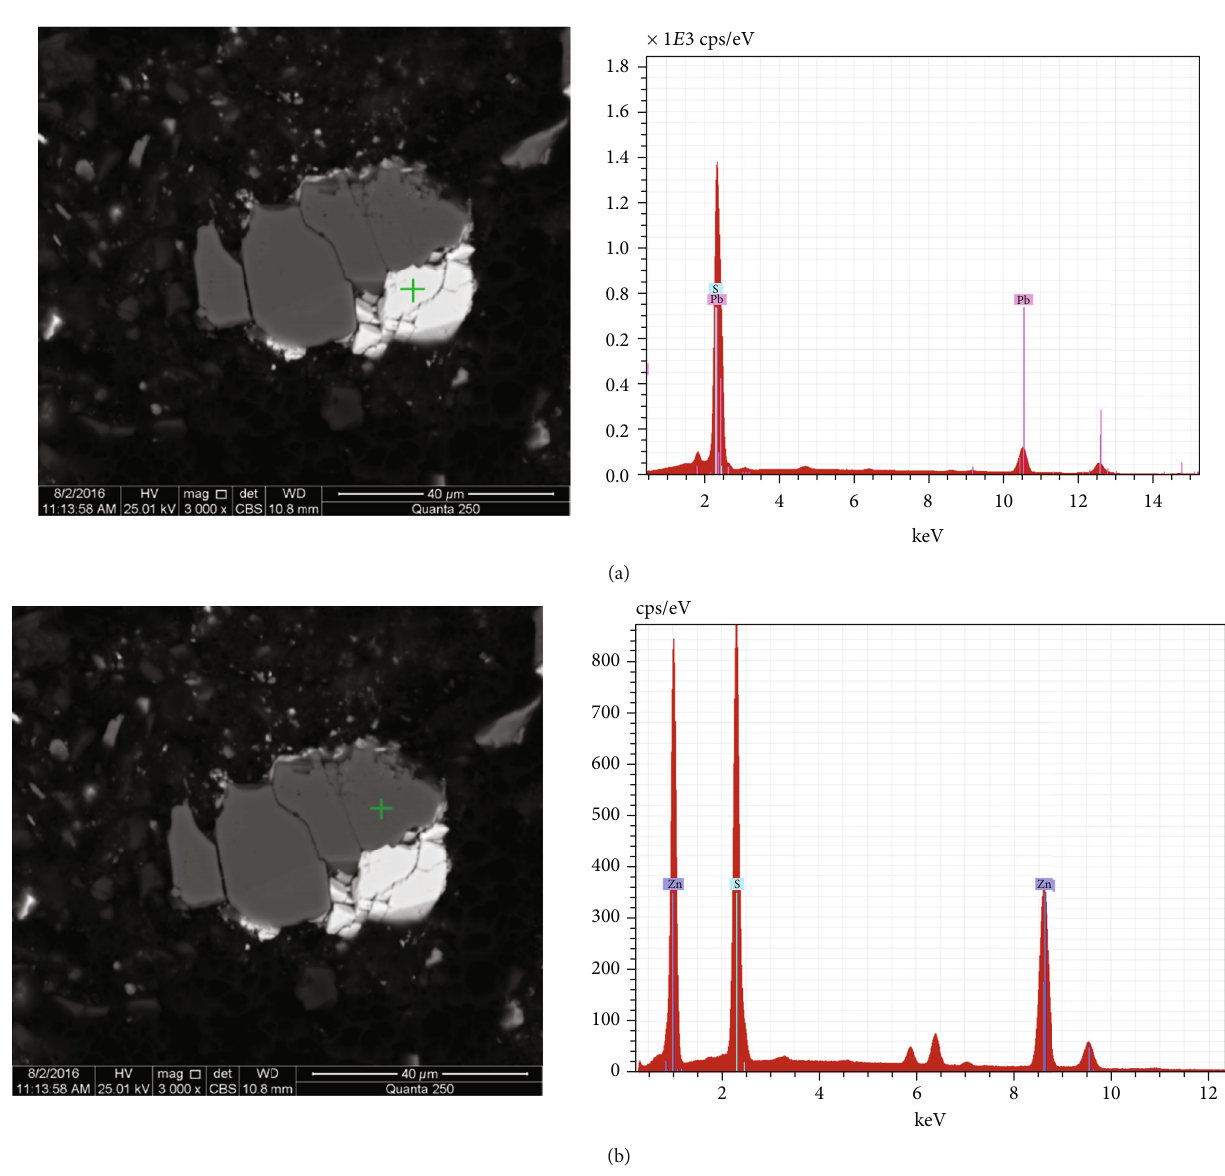
Figure 6: SEM and EDS images of lead-zinc ore after continuous microwave